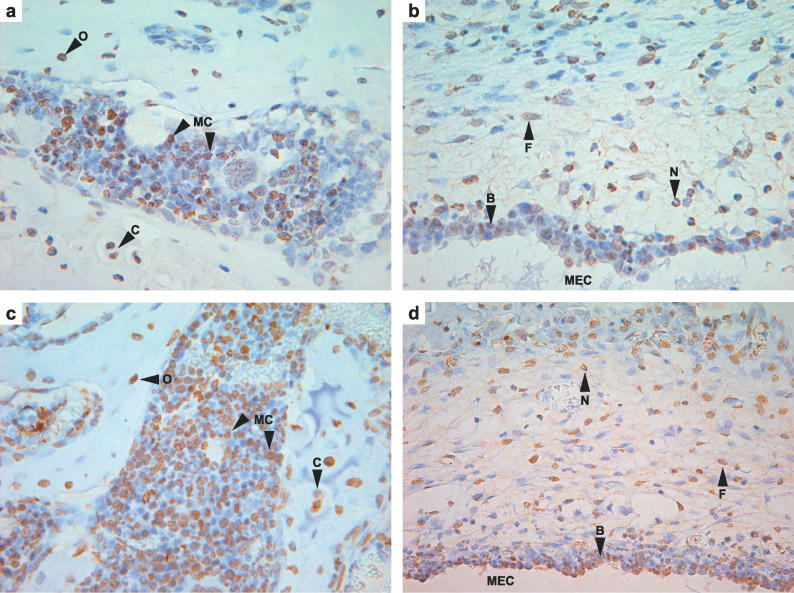
Evi1 Protein Immunostaining in 13-d-Old Jbo/+ and Wild-Type Mice with Acute OM(a) Jbo/+ positive myeloid cells in temporal bone marrow ×600. Note chondrocytes and osteocytes are also strongly positive. (b) Jbo/+ mucoperiosteum has positive neutrophil leukocytes, fibroblasts, and basal epithelial cell nuclei ×600. (c) +/+ similar pattern of staining in bone marrow ×600 and (d) +/+ inflamed mucoperiosteum ×600. B, basal epithelial cell nuclei; C, chrondrocyte; F, fibroblast; MC, myeloid cell; N, neutrophil leukocyte; O, osteocyte